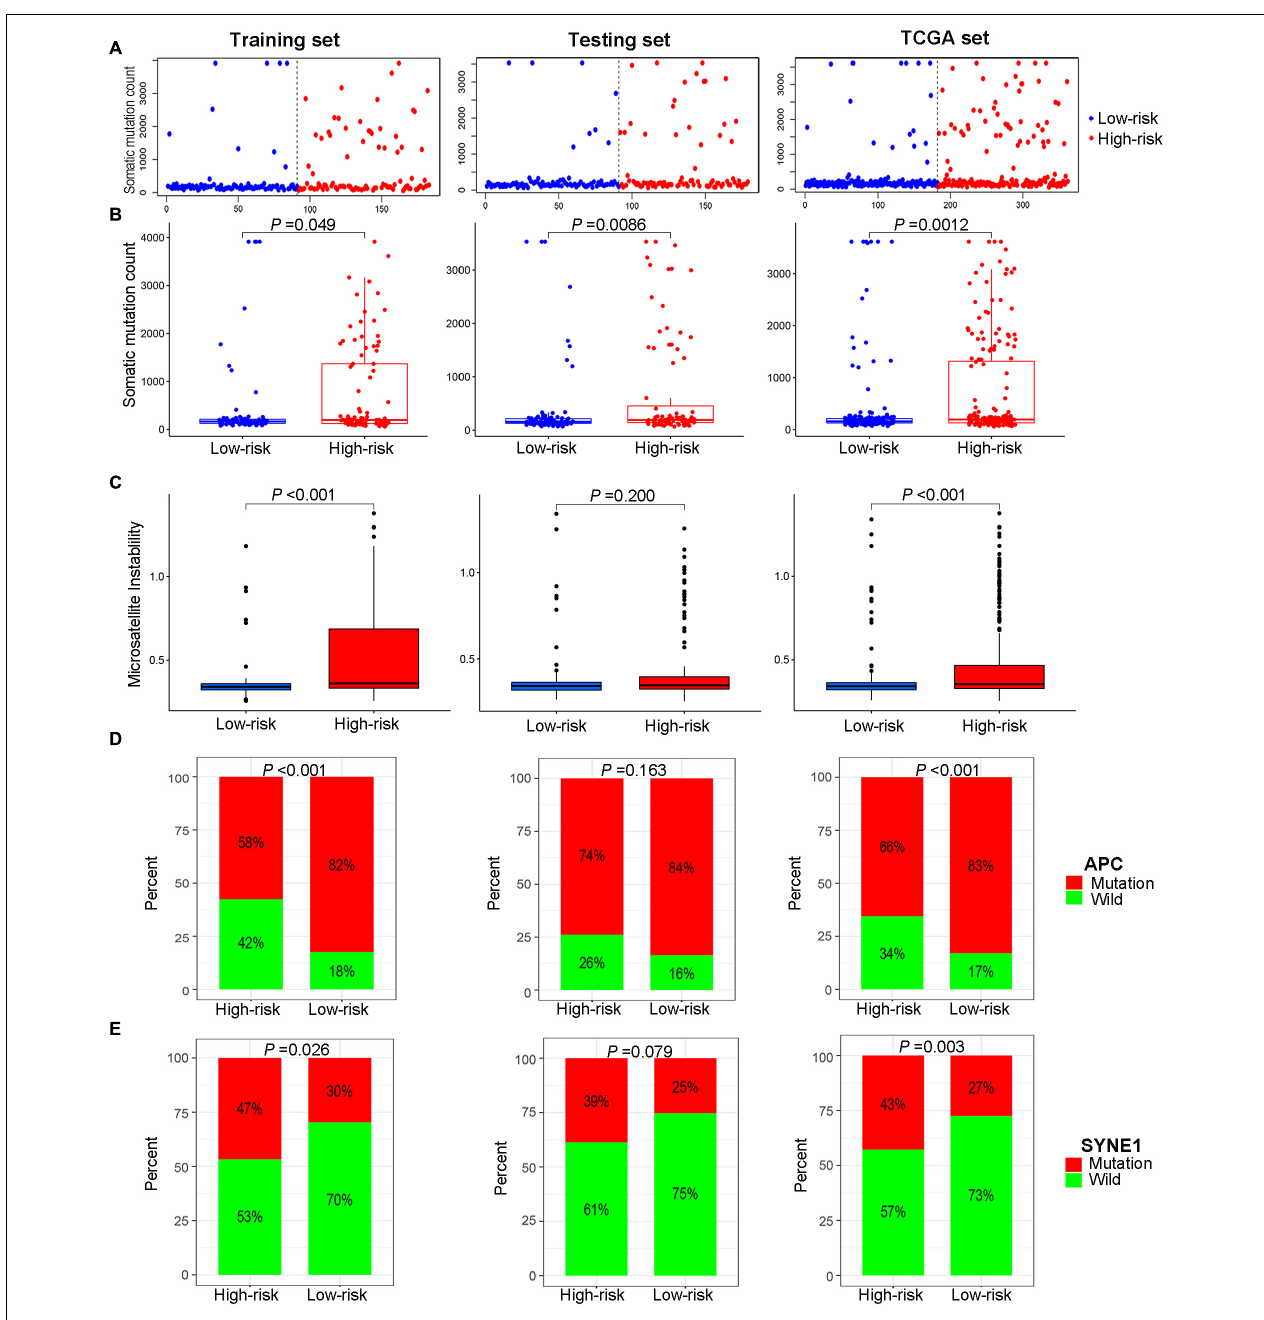
FIGURE 5 | Relationship between genome instability and the risk score calculated by the lncRNA signature. (A) Distribution of somatic mutation count of patients sorted by increasing risk score. (B) Cumulative somatic mutation number of patients in the high-risk group and low-risk group. (C) Microsatellite instability score of patients in high- and low-risk groups. (D) Proportion of APC mutations in the high- and low-risk groups. (E) Proportion of SYNE1 mutations in the high- and low-risk groups. All illustrations are shown in the sequence of the training set, testing set and TCGA